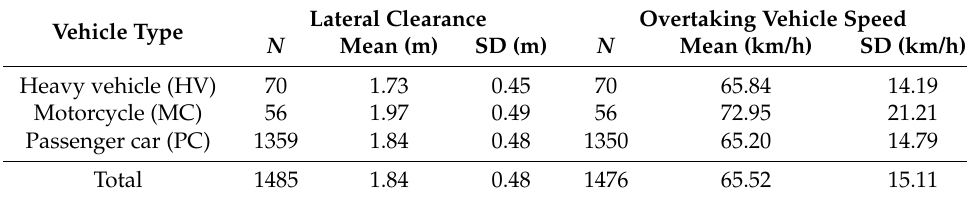
Table 3. Number of observations ( N ), mean value, and standard deviation (SD) of lateral clearance and overtaking vehicle speed, considering each overtaking vehicle